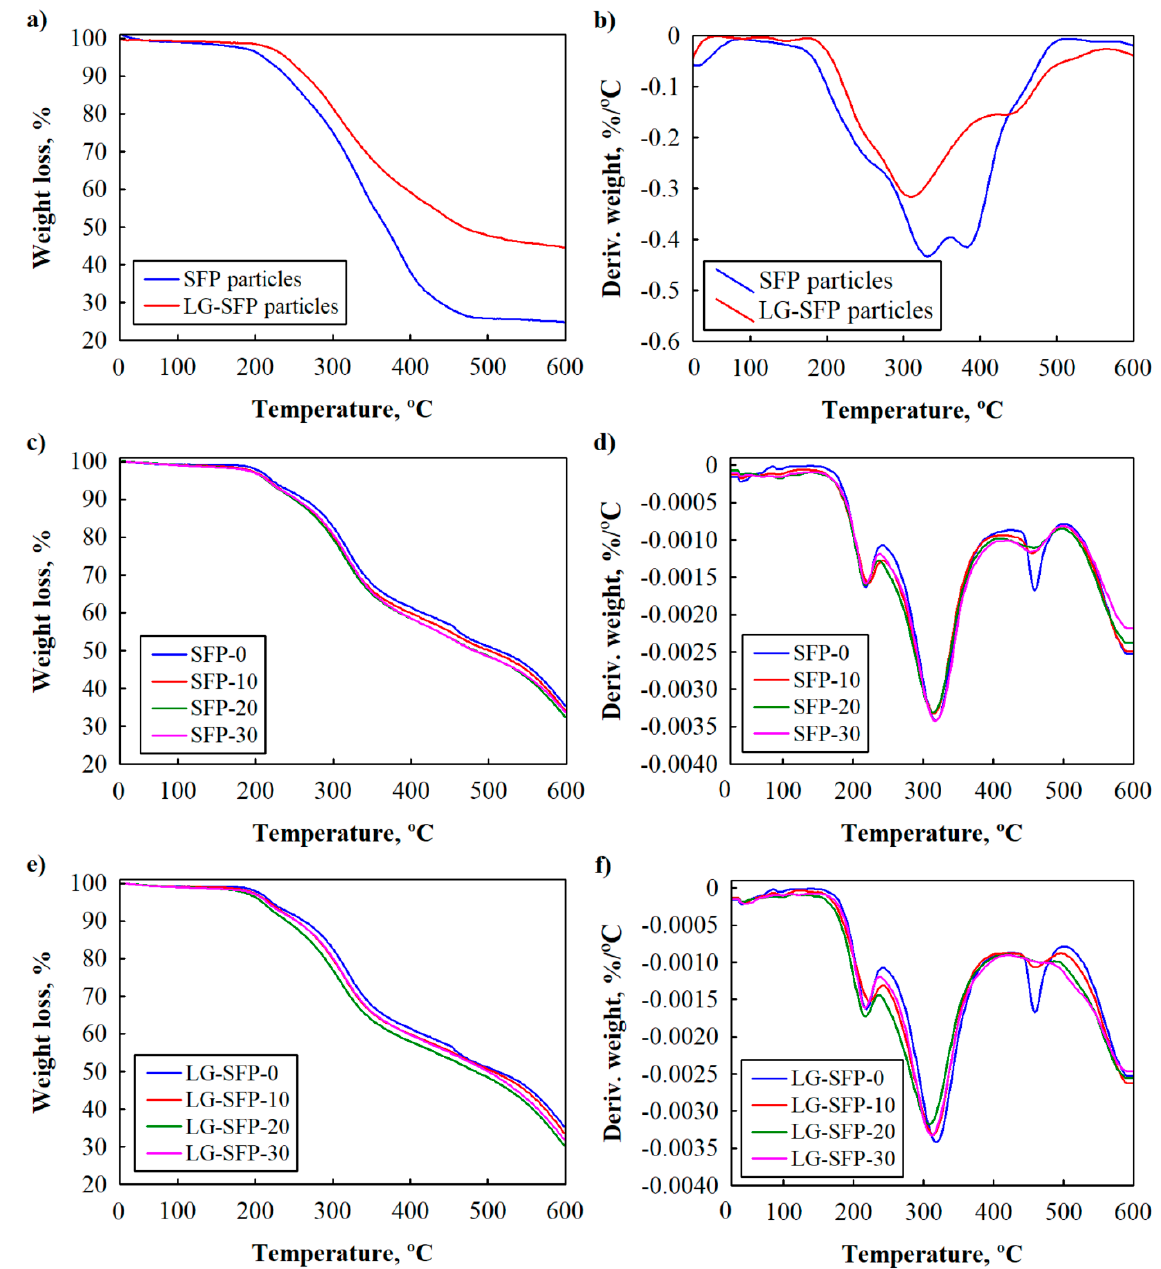
Figure 9. Thermal stability of SFP particles, LG-SFP particles, PUR-REF, SFP and LG-SFP modified PUR foams: ( a ), ( c ) and ( e ) TGA and ( b ), ( d ) and ( f ) DTG.